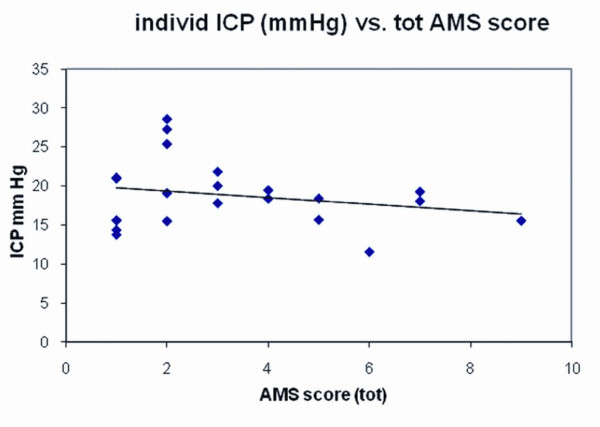
AMS symptom score vs. estimated ICP. 22 volunteers had AMS symptoms ranging from 1 (e.g. mild headache) to 9 (e.g. incapacitating headache with nausea, dizziness and sleep disturbance). AMS plotted against ICP shows a relative lack of correlation (r = 0.05).